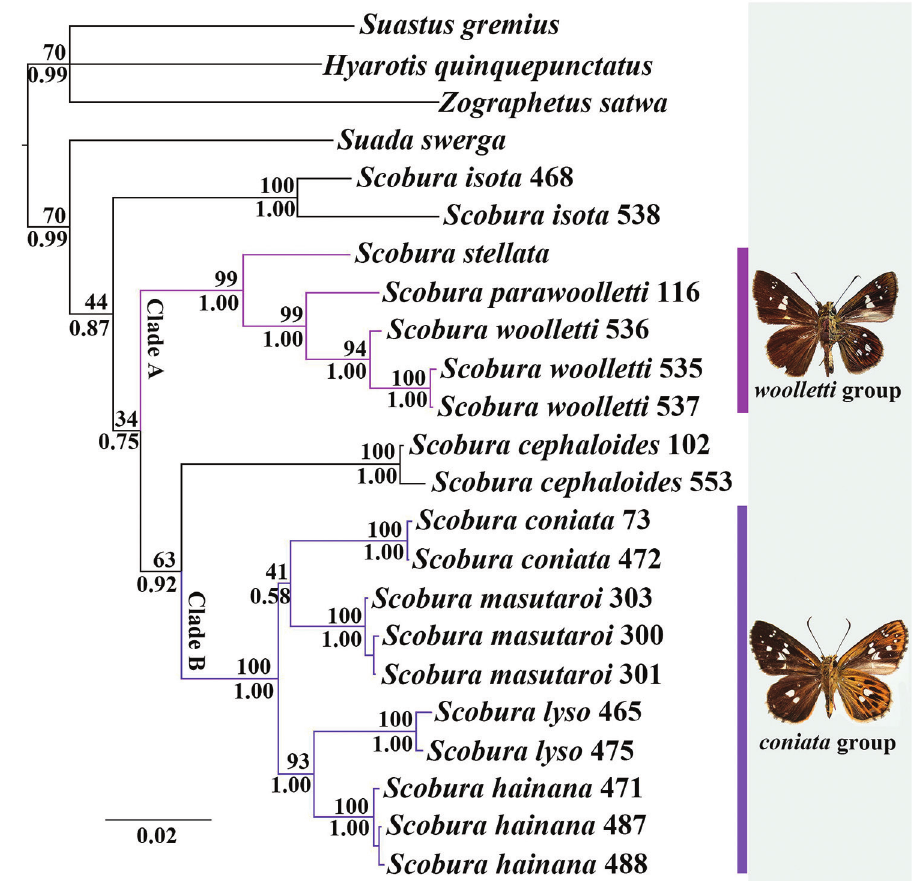
Figure 1. Majority-rule consensus tree from the Bayesian analysis (BI) of the concatenated COI and EF-1 α sequences. Values at nodes represent the bootstrap support (BS) values of the maximum likelihood (ML) and the posterior probabilities (PP) of BI analyses, respectively